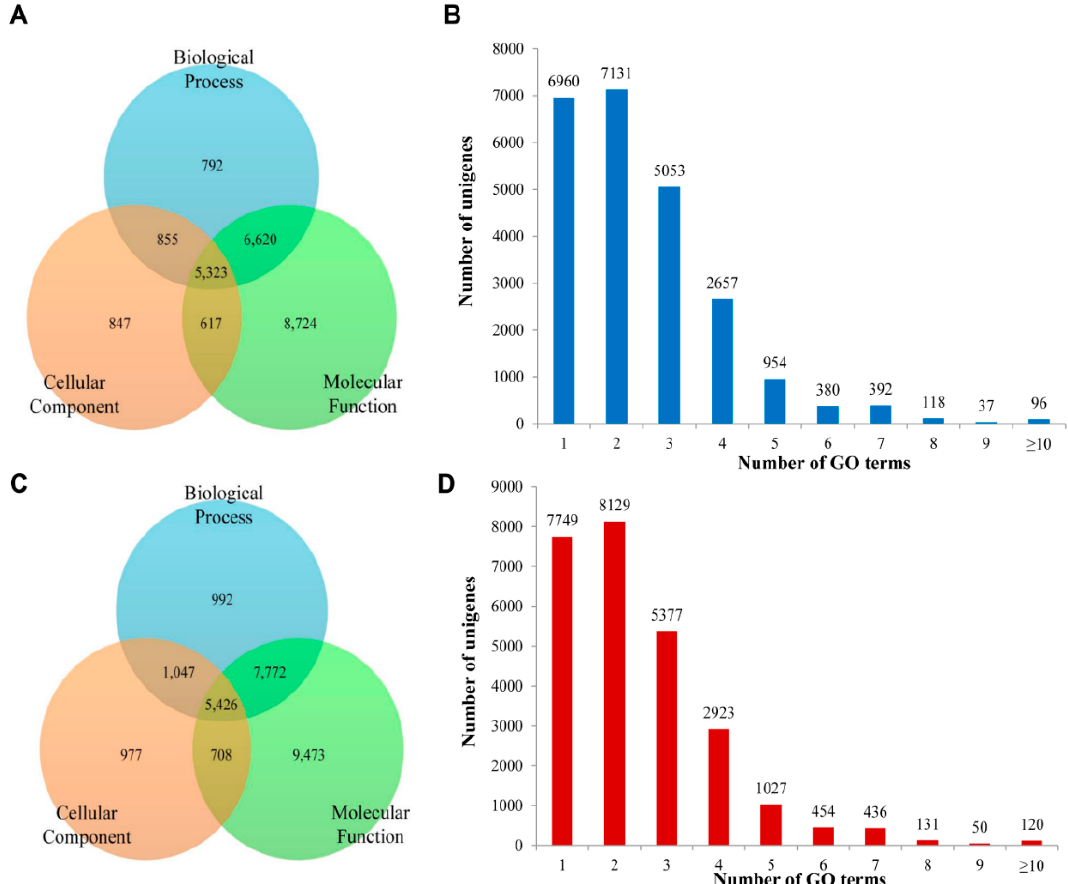
Figure 8. The functional prediction of unigenes under GO classification. ( A ) The distribution of the unigenes of A. chejuensis to GO biological function, cellular component and molecular function; ( B ) The number of GO terms ascribed to unigenes of A. chejuensis ; ( C ) The GO functional prediction of A. quelpartensis unigenes; ( D ) The number of GO terms ascribed to unigenes of A. quelpartensis .